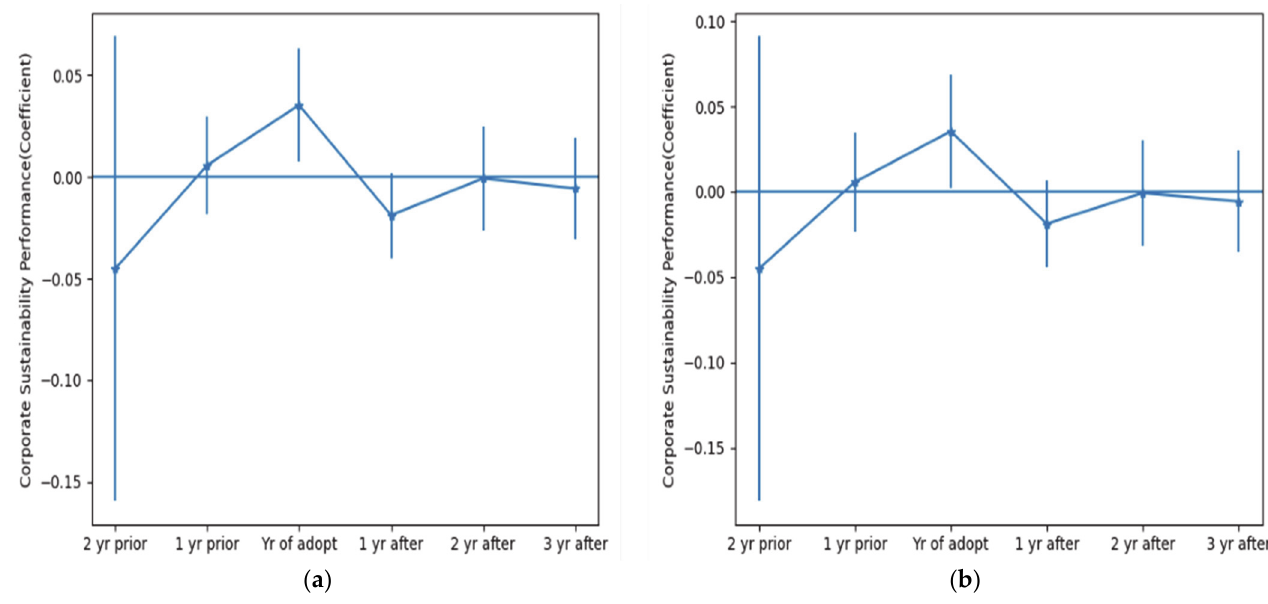
Figure 5. A multi-period DID model for testing parallel trends and dynamic effects on corporate sustainability performance. ( a ) 90% confidence interval; ( b ) 95% confidence interval.